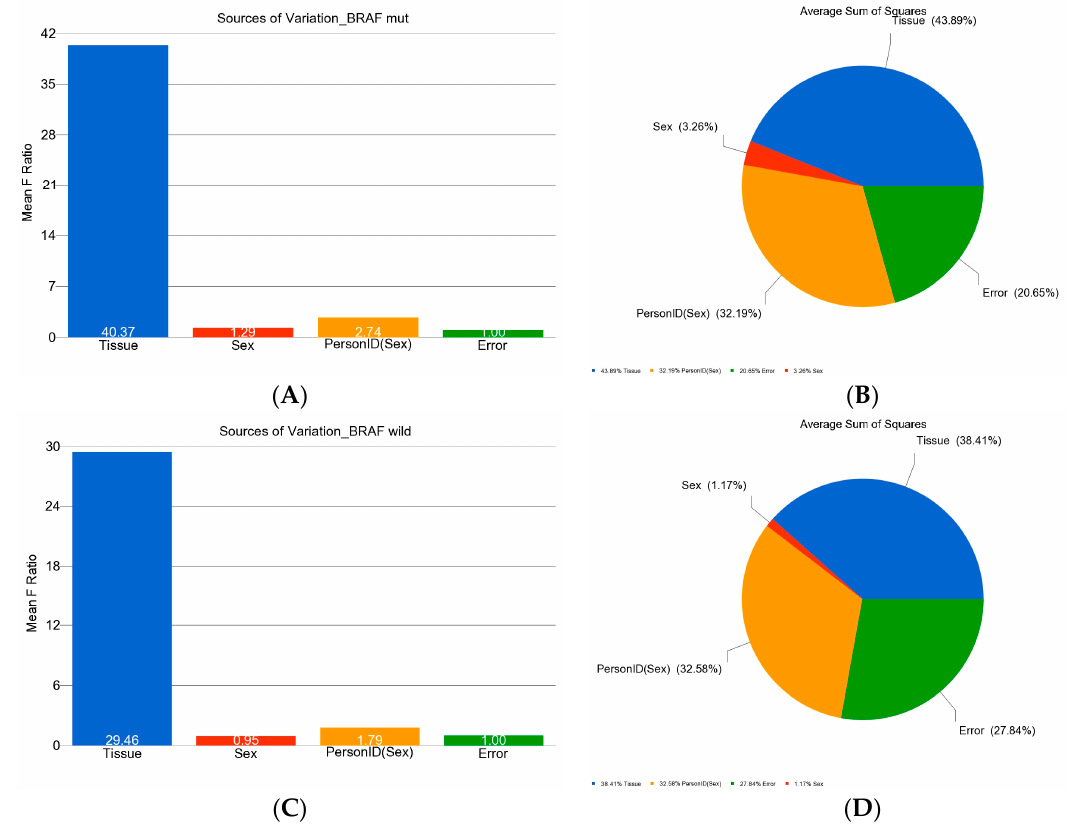
Figure 2. Variations of beta values in DML (at FDR 0.05) in patients with BRAF V600E mutation and wild type. The mean F-Ratio (F-statistics for the factor/the F-statistics for the model error) representing the significance of the factor in the ANOVA model are shown in the bar graph ( A , C ). The sum of squares in the ANOVA model representing the proportion of the variation explained by the factors is shown as the pie chart ( B , D ). The proportion of variation that can be explained by the “person-to-person variation” is shown in orange; the proportion that can be explained by the “tissue type (tumor or normal)” is shown in blue; the proportion that could not be explained by the ANOVA model (the “error”) is shown in green. The variation in BRAF mutation is shown in the top panel ( A , B ) while the variation in the wild type is shown in the bottom panel ( C , D ). In patients without BRAF mutation, there were 247 DML that were significant at FDR 0.05 level (see Figure 2C,D).